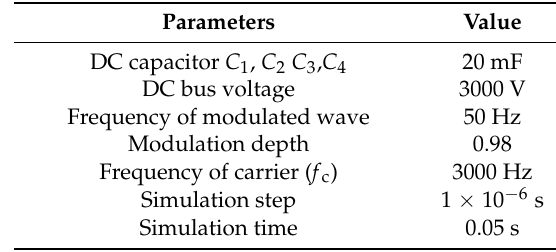
Table 2. Simulation Parameters.